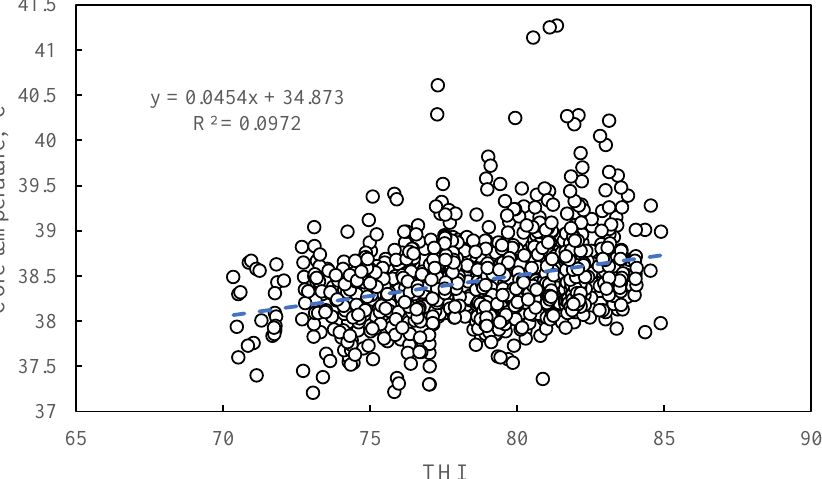
Figure 2. The correlations between temperature and humidity index and core temperature. The THI value was calculated based on the experimental data of 1029 sets of air temperature and relative humidity. The dots represent the scatter plot of the core temperature of the sow corresponding to the THI. The dotted line represents the model estimate based on the linear regression of sow core temperature with THI. The linear regression equation here is: y = 0.0454x + 34.873 (where y stands for core temperature (°C) and x stands for THI) (R 2 = 0.0972, p < 0.0001).